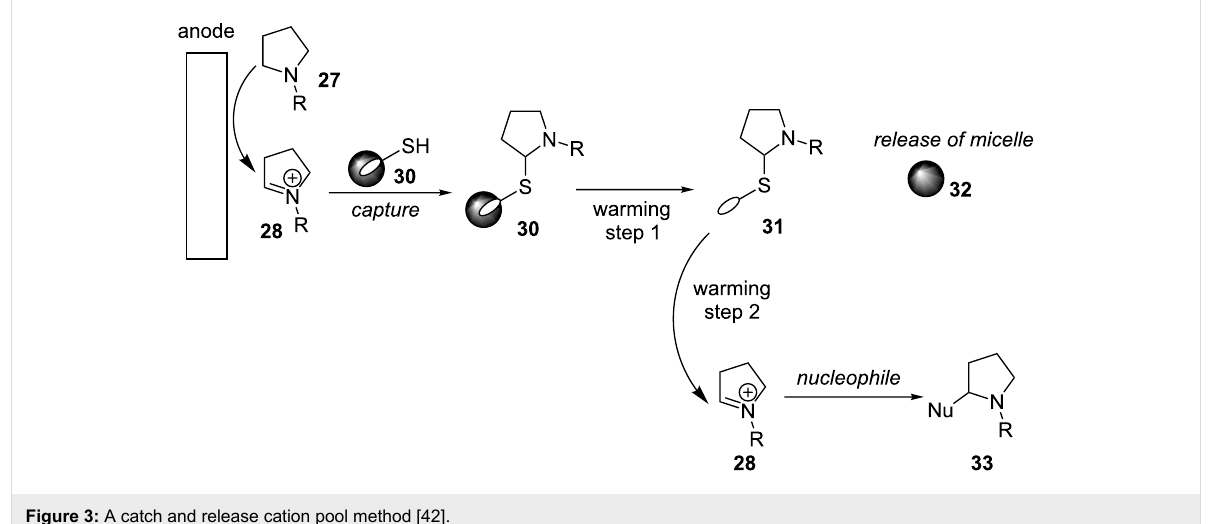
Figure 3: A catch and release cation pool method